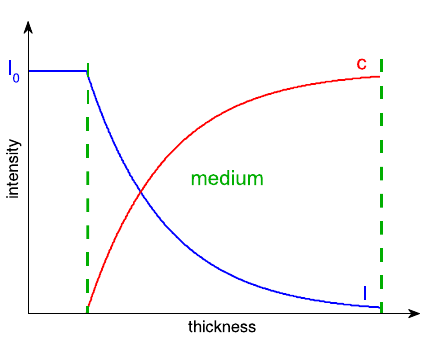
Figure 3: Beer-Lambert law with the exponential decrease of the laser pulse intensity I (blue) during the propagation through a medium (green) and corresponding correction term c (red) the received waveform, the peaks and borders between the peaks have to be detected. In the integral correction method (Richter et al., 2014b), the proportion p i is calculated as a ratio of the ampli- tude of the received waveform at the sample point to the reference value.